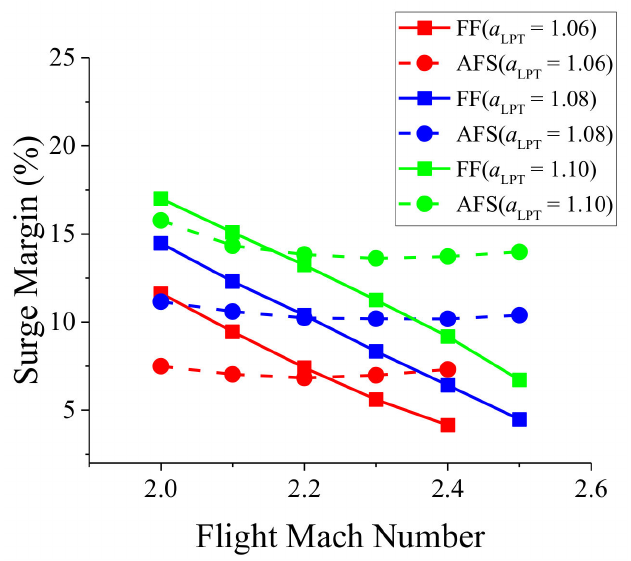
Figure 39. The Variations of Surge Margins of Front Fan and AFS at the conditions of Different Throat Area Coefficients of Low-Pressure Turbine Inlet Guide Vane ( α LPT ).